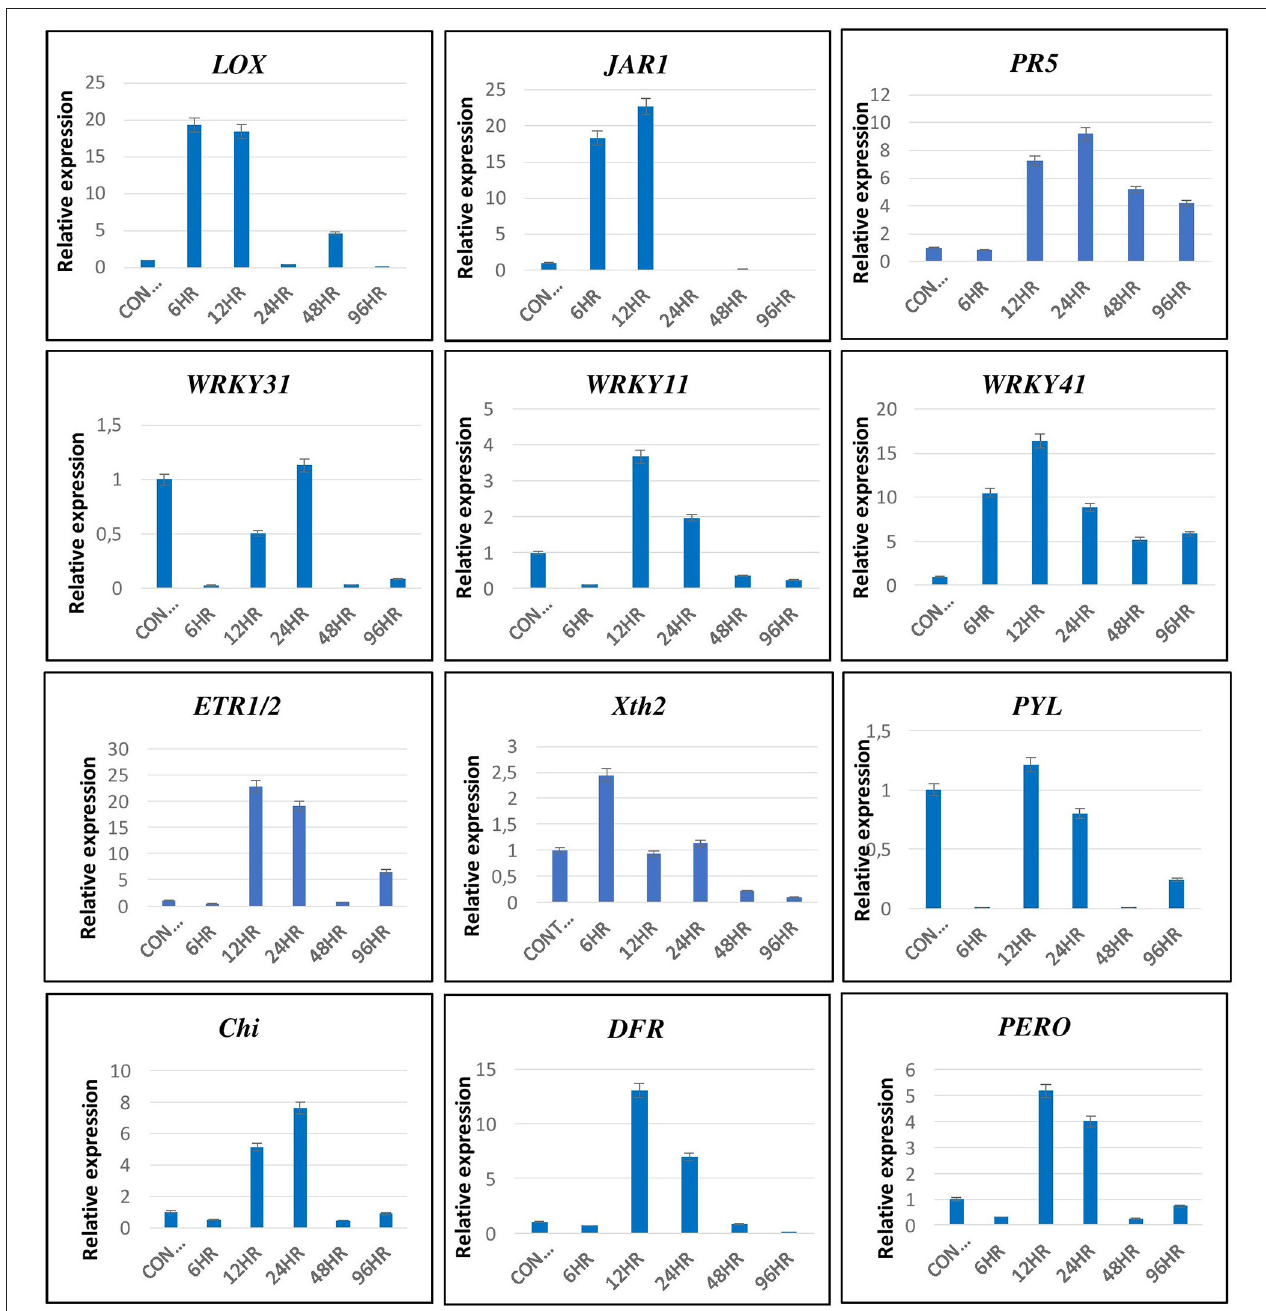
FIGURE 11 | The validation of expression of selected genes by qRT-PCR showed significant difference in their expression at different time intervals. Error bars show ± SD among the biological triplicates.